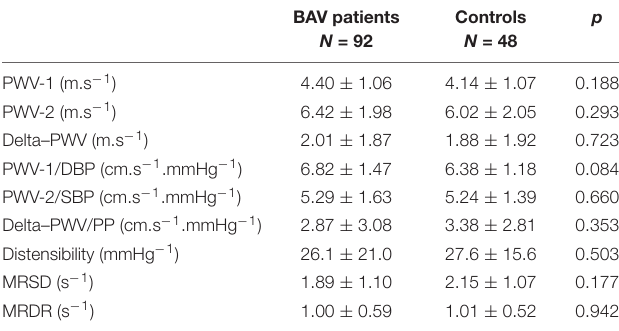
TABLE 2 | Carotid stiffness parameters of BAV patients and controls.